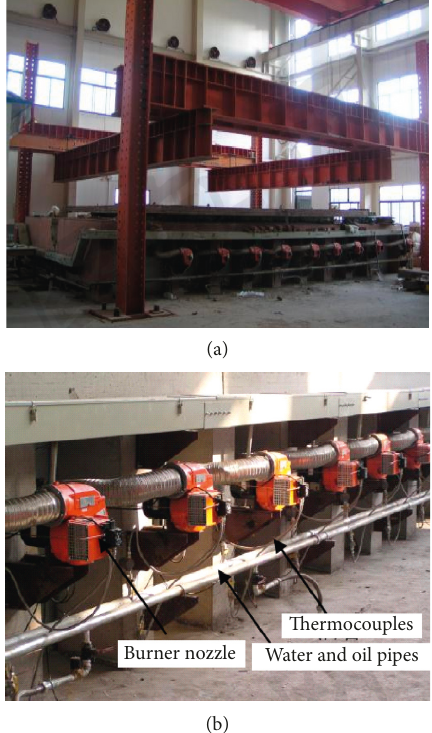
Figure 2: Picture of the furnace. (a) Complete picture. (b) Con- struction